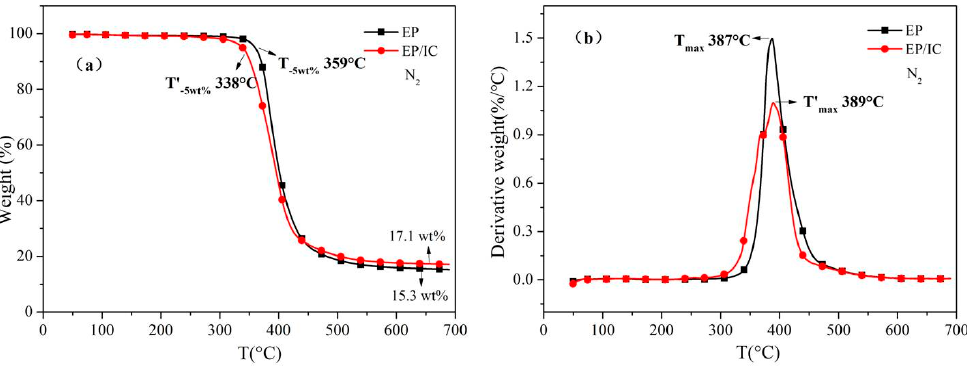
Figure 6. ( a ) TGA and ( b ) DTG curves of EP and EP/IC under N 2 .